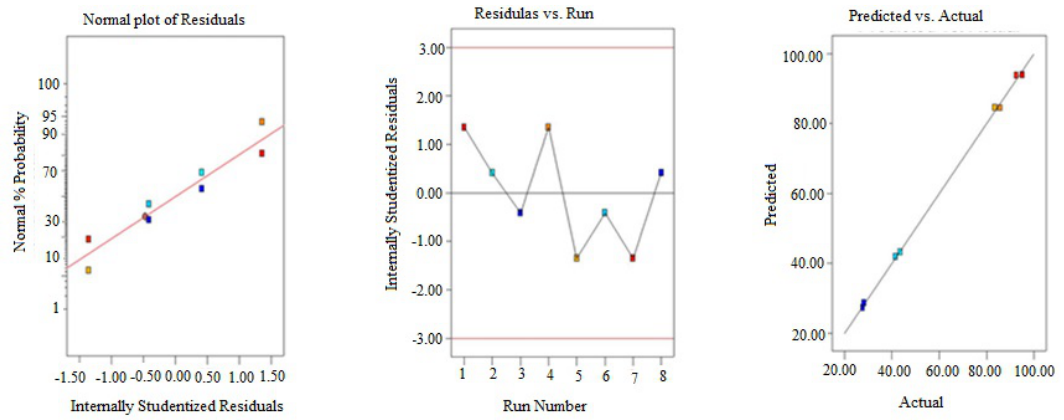
Figure 7. Diagnostics plots for 2-level factorial design, including normal plots of residuals, residual vs. run, and predicted vs. actual